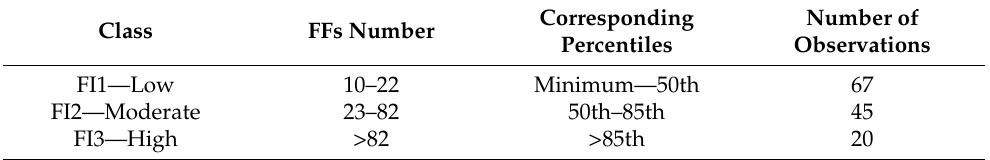
Table 3. Specifications for the classification of FEs according to flood impact magnitude (FI index)